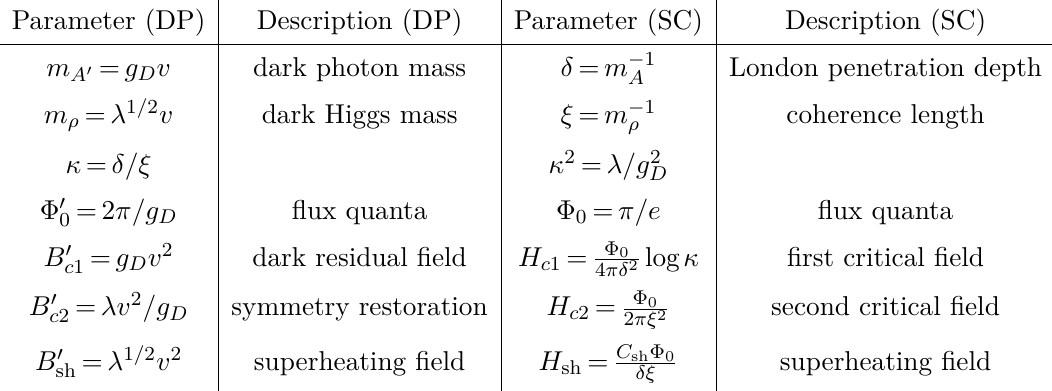
Table 1 . A list of useful variables and terminology, their definitions in the dark photon (DP) and superconductor (SC) literature, as well as how the various variables and terminology are related/analogous to each other. A more detailed discussion can be found in [25] and section